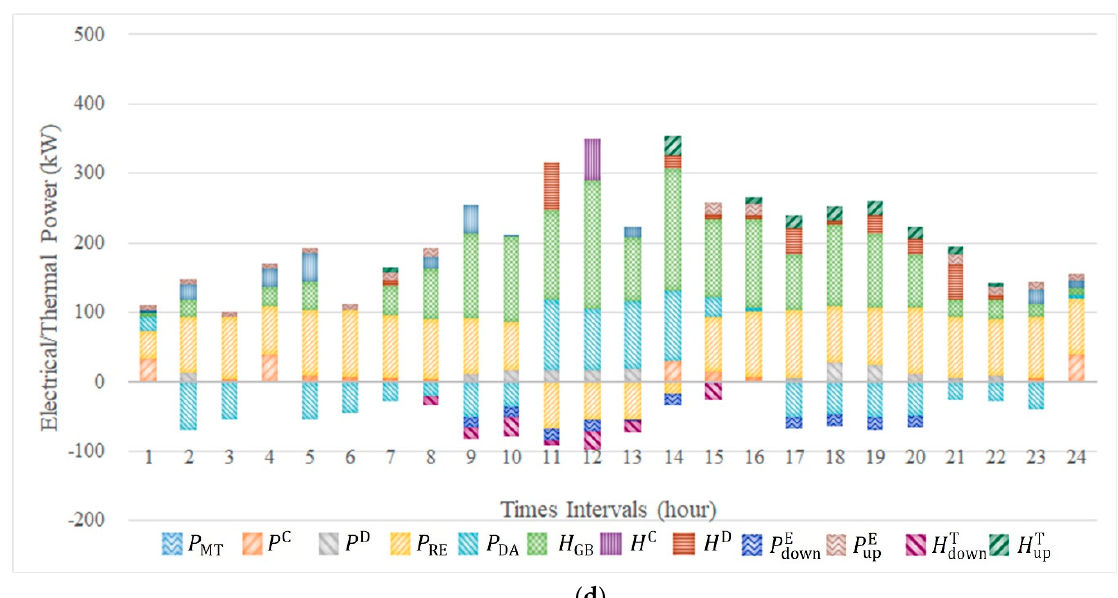
Figure 2. ( a ) The optimal operation results in Case 1 on the typical winter day; ( b ) The optimal operation results in Case 2 on the typical winter day; ( c ) The optimal operation results in Case 3 on the typical winter day; ( d ) The optimal operation results in Case 4 on the typical winter day. Note : P E and H T stand for values of electrical and thermal loads shifted down, respectively. As the electrical down and thermal loads are positive values in Figure A6 etc. in Appendix B, values of P E set to be negative ones in Figure 2 for the purpose of clear expression.